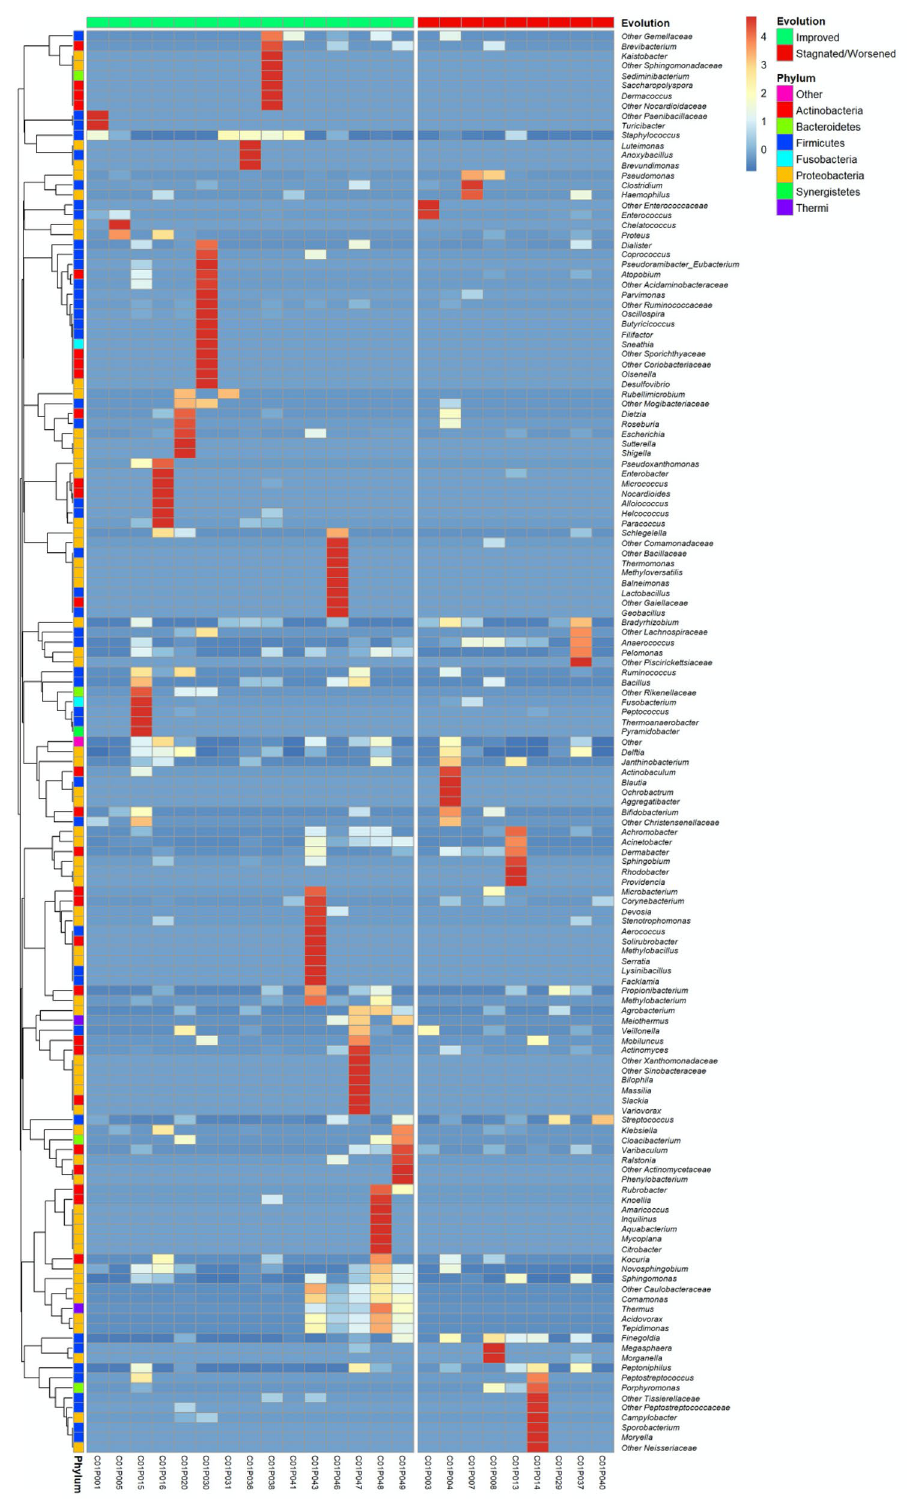
Figure 3. Heatmap of the PU microbiota’s standardised composition at D0 ranked according to wound evolution. Standardised relative frequencies of genera are used in order to see variations between groups even for low-abundant bacteria. Genera are classified according to agglomerative hierarchical clustering with complete